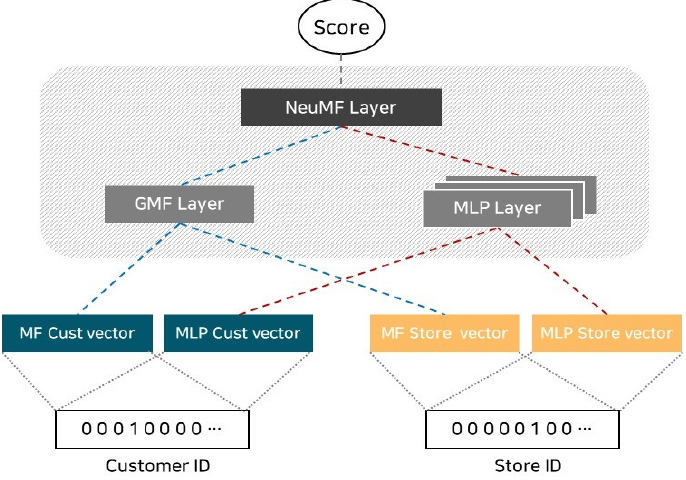
Figure 3. Structure of Base NMF.